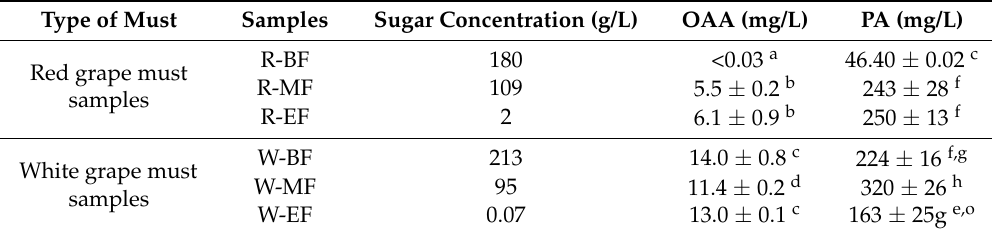
Table 2. Oxaloacetic (OAA) and pyruvic acid (PA) concentrations (mg/L) in white and red grape musts at different points of the grape must fermentation. Values with different letters are statistically different ( p < 0.05). Type of Must Samples Sugar Concentration (g/L) OAA